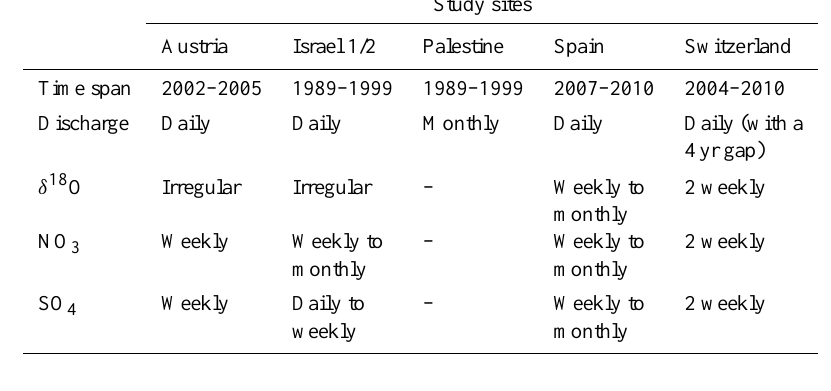
Table 2. Available data for the analysis.